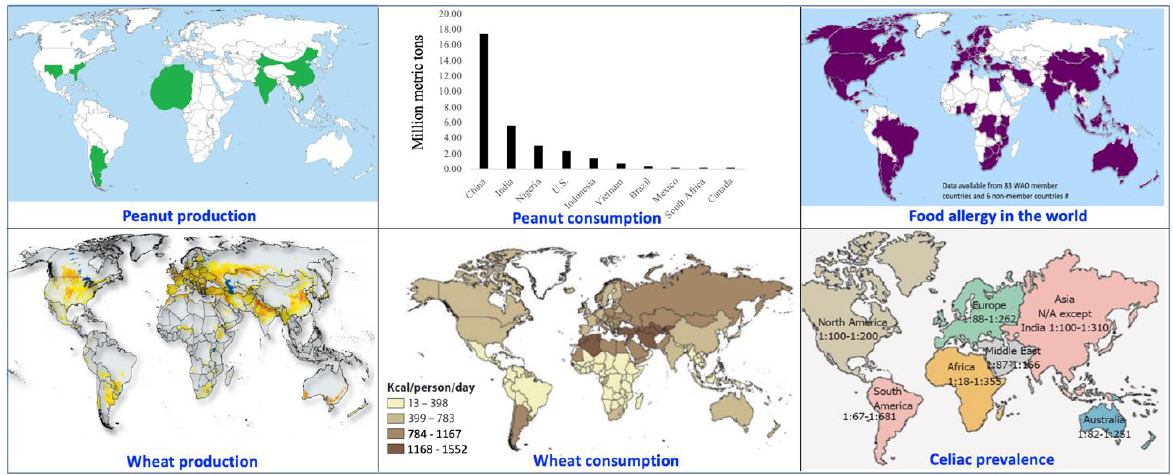
Figure 1. Figures from left to right showing the geographical distribution of the peanut- and wheat- production areas and where they are consumed. Figures on the extreme right show the geographical distribution of food allergies (top, primarily represented by peanut allergies) and celiac disease.